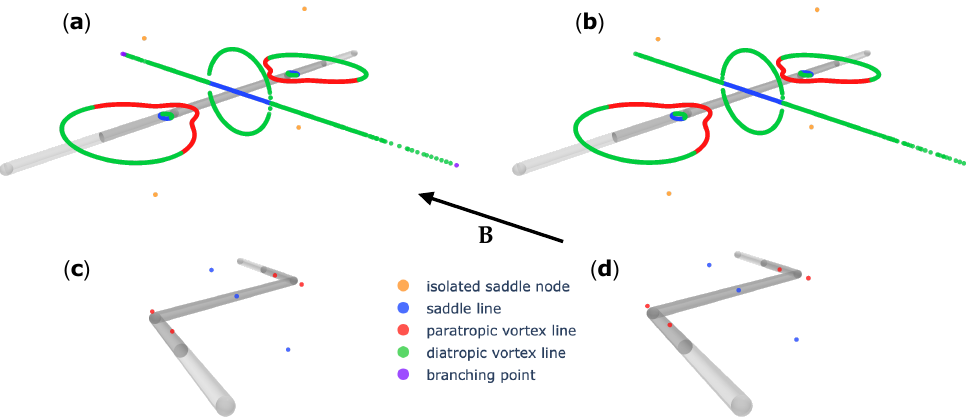
Figure 5. The stagnation graphs of the C 2 H 2 molecule in its equilibrium geometry with a magnetic field of ( a ) 0.05 B 0 , ( b ) 0.10 B 0 , ( c ) 0.15 B 0 and ( d ) 0.20 B 0 along the x -axis. The interactive version of these figures may be found in C2H2_B005.html , C2H2_B010.html , C2H2_B015.html and